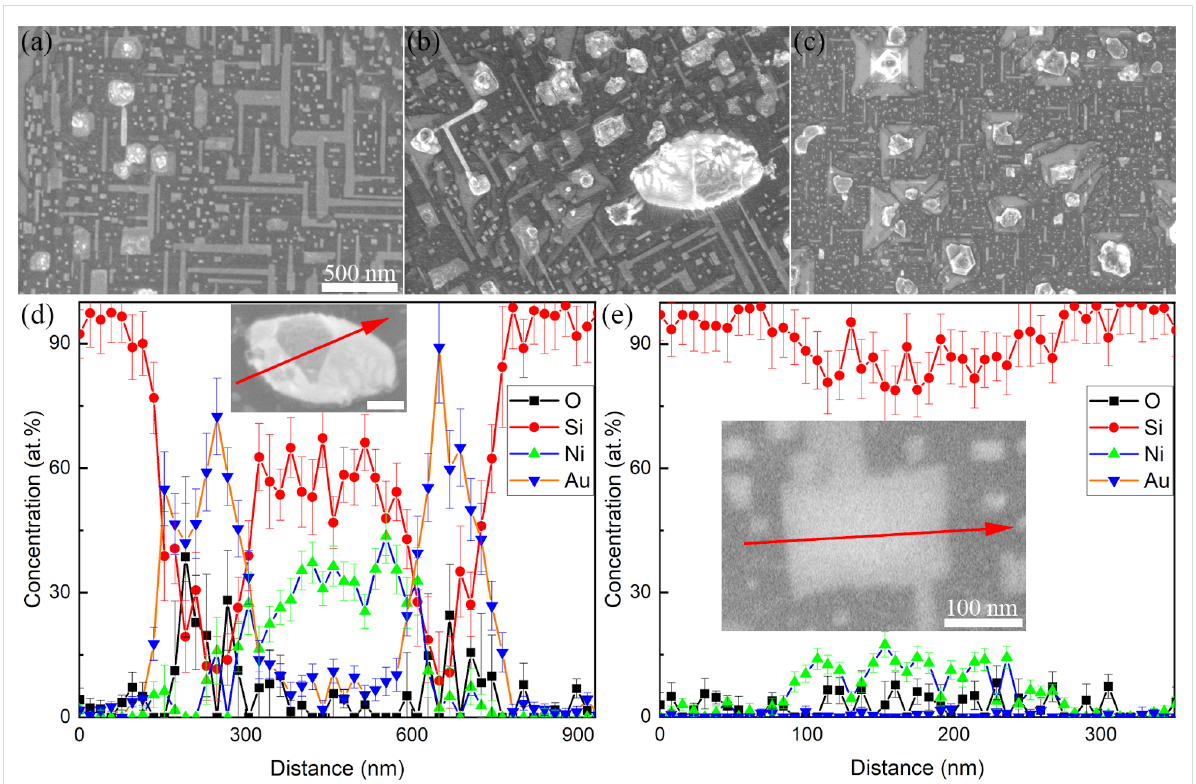
Figure 2: (a–c) Morphology inside the decomposition cavities. (d) Composition of the particle and (e) the line in 10Au10Ni. Images (a–c) correspond to 5Au15Ni, 10Au10Ni and 15Au5Ni, respectively. The scale bar in (a) is also valid for (b, c), and the scale bar of the insets in (d) is 200 nm.